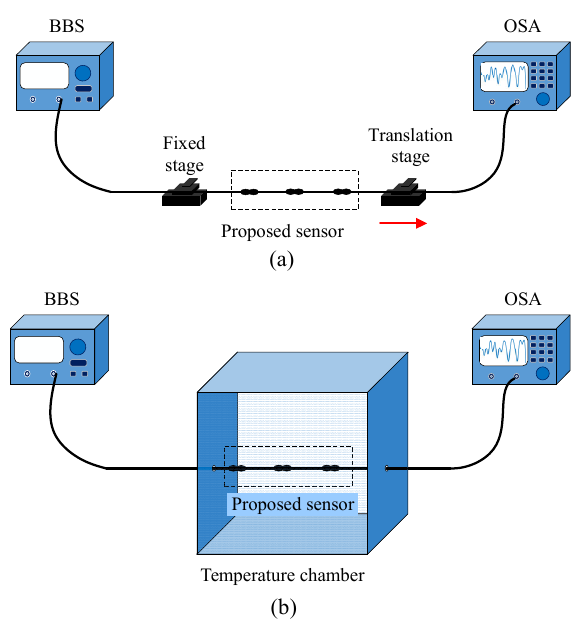
Fig. 4 Diagram of the experimental setups employing the proposed sensor for the sensing of (a) strain and (b) temperature.